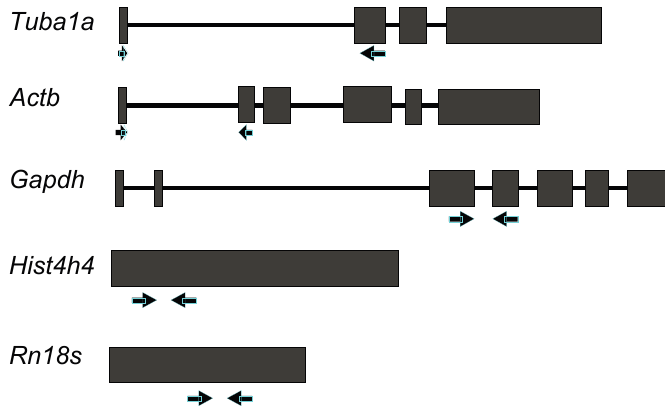
Figure 1. Gene structure of markers commonly used as internal controls for expression analysis during mouse lung development. Schematic representation of the gene structure of commonly used reference genes for expression analysis. Exons are represented as grey boxes and introns as black lines, while primer binding sites are shown with